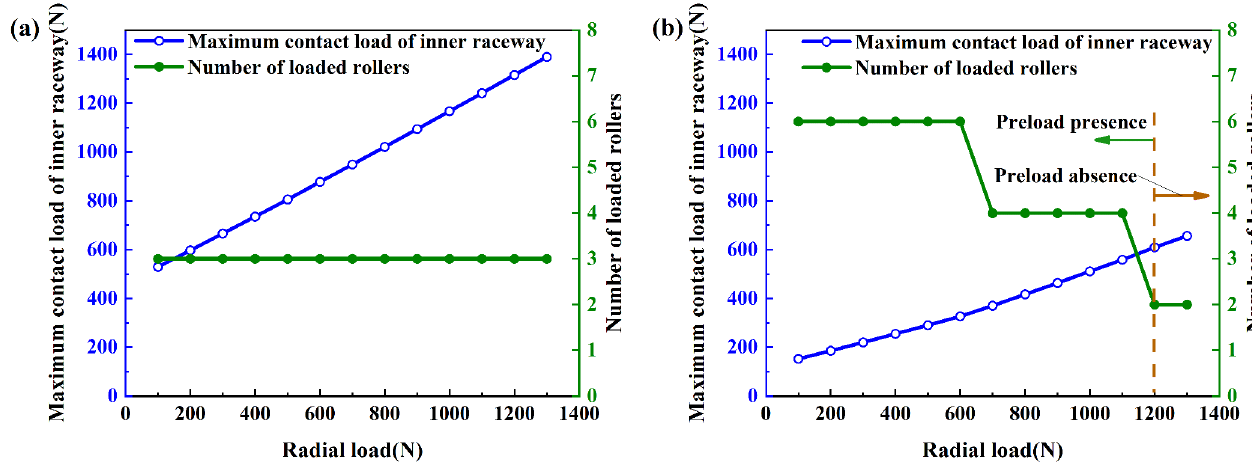
Fig. 9. The maximum contact load variation of the inner raceway and the number of loaded rollers variation under the different radial loads: (a) single-pressed state; (b) double-pressed